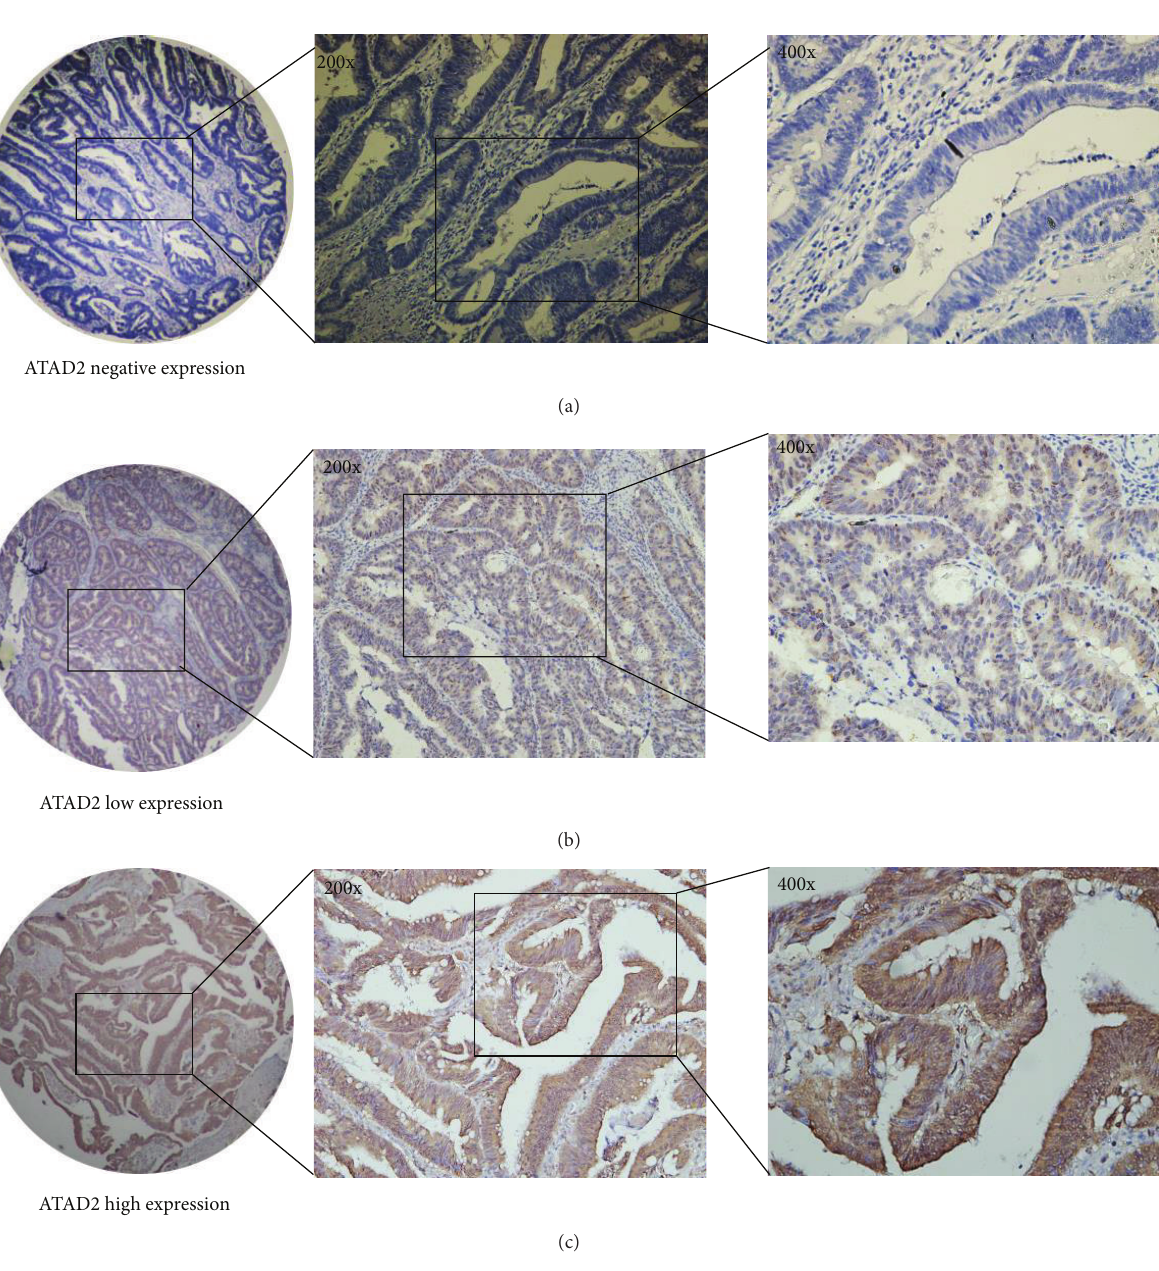
Figure 2: ATAD2 expression in CRC was determined by immunochemistry. (a) Negative expression of ATAD2, (b) low expression of ATAD2, and (c) high expression of ATAD2. Representative images are shown at 200x and 400x magnification,